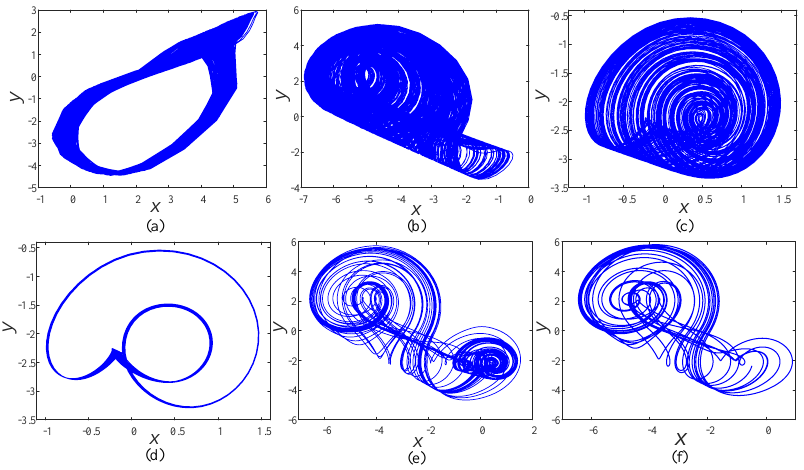
Figure 2. Phase diagrams with different q : ( a ) q = 0.21; ( b ) q = 0.35; ( c ) q = 0.5; ( d ) q = 0.52; ( e ) q = 0.6; ( f ) q = 0.9.